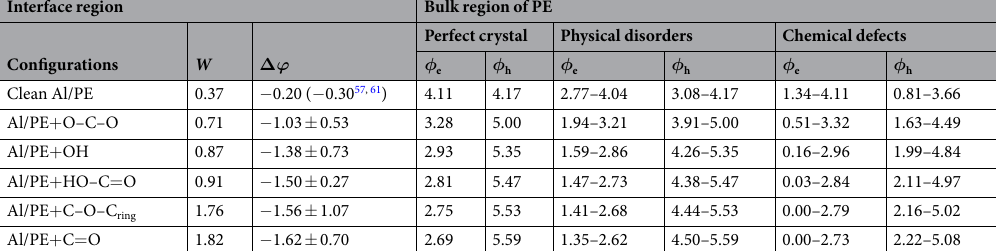
Interface vacuum energy shift. Because of the interfacial dipole moment D , the vacuum energy levels at Al and PE sides are misaligned by Δ ϕ , as illustrated in Fig. 1(b). Computed values of Δ ϕ are shown in Table 3 and Fig. 3(a). For the interfaces considered, Δ ϕ is negative, signaling a downward shift of the vacuum energy level in the PE side. The increasing trend of Δ ϕ from Al/PE to Al/PE + O–C–O to Al/PE + OH to Al/PE + HO–C = O and to Al/PE + C = O indicates the growing strength of D . This dipole moment originates from the rearrangement of the electron density distribution across the two sides of the interface, driven by the Pauli repulsion 57–59 . Such a “pillow effect” 60 drops the PE vacuum level by  0.2 eV, consistent with the downward shift of  0.3 eV measured for a n -CH 3 (CH 2 ) 44 CH 3 (tetratetracontane) monolayer absorbed on an Al(111) surface 57, 61 , of which the structure is similar to the Al/PE interface examined. The permanent dipole moments induced by the O-containing groups depend strongly on their orientation. Thus, three positions of such groups in the second layer of the interface region were considered, resulting in a range of calculated Δ ϕ shown in Fig. 3(a). The most/less negative value of Δ ϕ was obtained with parallel/ anti-parallel O-containing groups in the top two layers. For Al/PE + C–O–C ring interface, Δ ϕ can be as large as − 2.62 eV while for Al/PE, Δ ϕ is rather small when the O-containing groups are anti-parallel. Computed Δ ϕ of Al/PE + O–C–O is larger (  − 0.5 eV) due to the electronegativity of O while for Al/PE + OH, Al/PE + HO–C = O, Al/PE + C–O–C ring and Al/PE + C = O interfaces, Δ ϕ is more negative. The reason is that in addition to the perma- nent dipole moments, Al–O and Al–C bonds also contribute to D by rearranging the interface charges. In summary, the primary factors that are responsible for D and Δ ϕ are the “pillow effect”, the permanent dipole of polar groups, and the formation of polar bonds, of which the last two factors are dominant. Both of them may be introduced by the O-containing groups, significantly dropping the vacuum energy level in the PE side (by > ∼ 1.0 eV) and greatly affecting the charge injection barriers. Charge injection barriers. Given the Δ ϕ determined, the electron and hole injection barriers of the Al/PE inter- faces, i.e., φ e and φ h , defined as the energy difference between the Fermi level and the PE band edges or trap levels